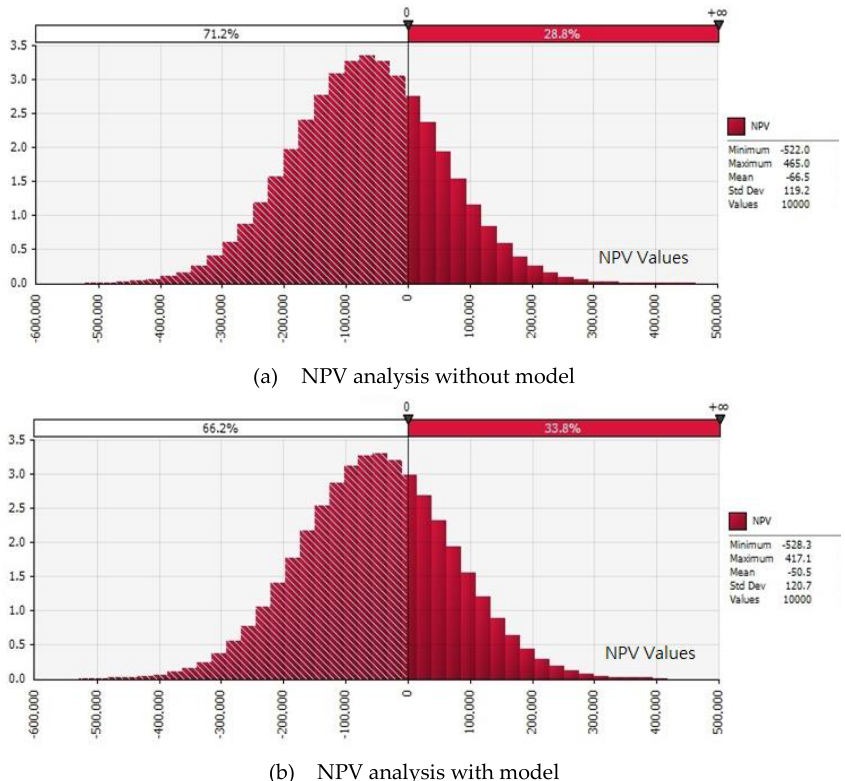
Table 7. Cost and profit with Fe content variation (fluctuating price ratio). Ni Content Variable